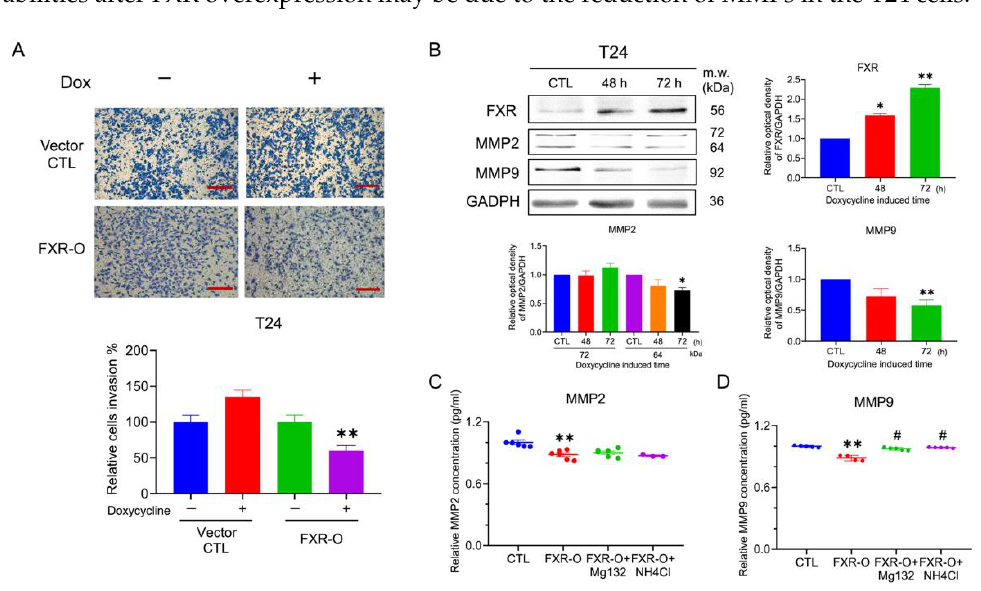
Figure 5. The effect of MG132 and NH4Cl on integrin expression after FXR overexpression. ( A ) In- tegrin β1, integrin β3, MLC and p-MLC were analyzed by Western blotting in the TSGH8301 and T24 cells with or without MG132 or NH4Cl. GAPDH was used as the loading control. ( B ) The bar graphs show the relative quantitative analysis of the aforementioned proteins. ** p < 0.01 compared with the control group; # p < 0.05 compared to the FXR-O group.